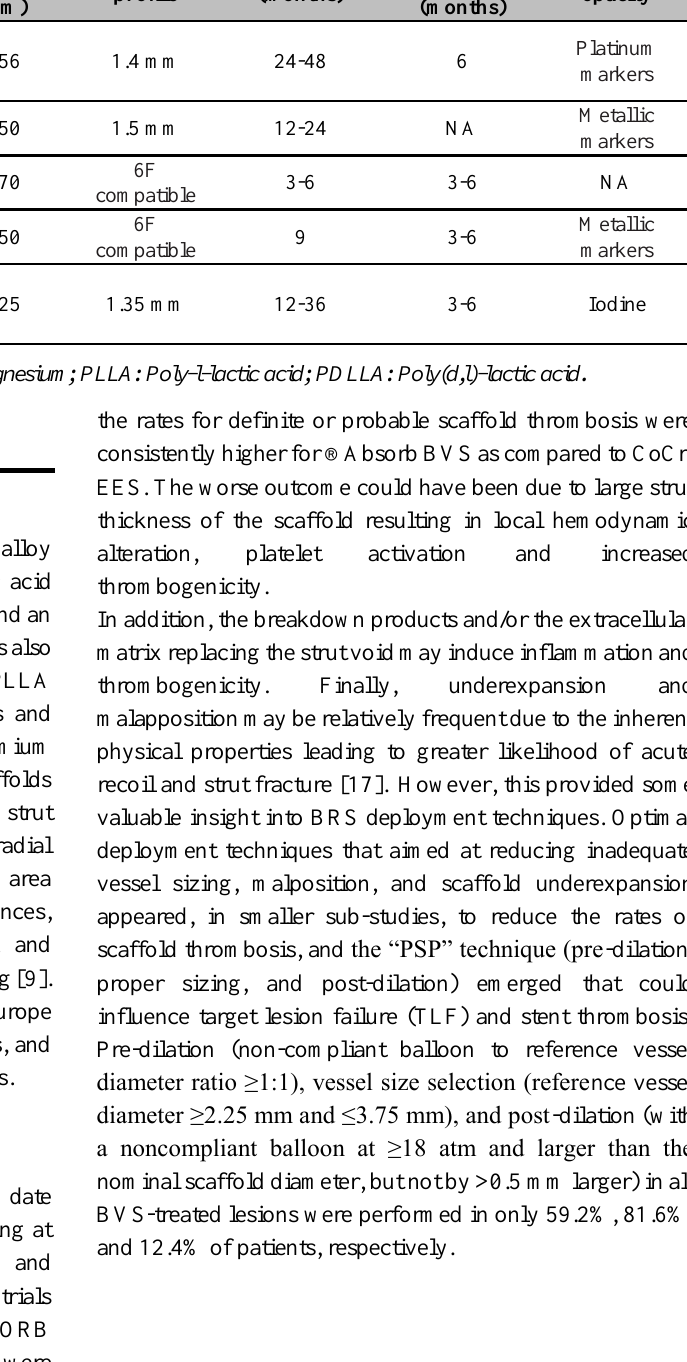
Table 1: Design characteristics of bioresorbable scaffold technologies with CE mark